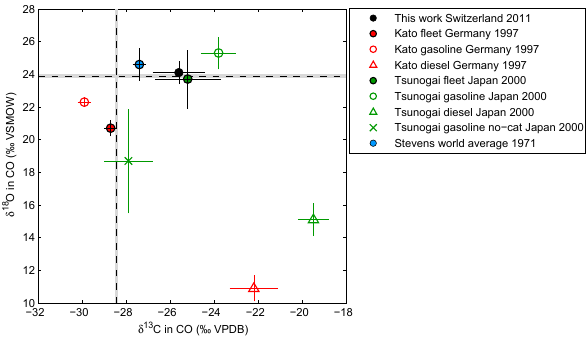
Fig. 6. δ 18 O versus δ 13 C in traffic CO from our work and previous studies: Kato et al., 1999a (Kato); Tsunogai et al., 2003 (Tsunogai); Stevens et al., 1972 (Stevens). The year shown in legend is the year when measurements were done. The dotted black lines indicate the δ 18 O in atmospheric oxygen (Barkan and Luz, 2005) and the aver- age δ 13 C value of the fuel in our study, as estimated from the δ 13 C value of CO 2 ; the shades indicate their standard errors, and their intersection shows the hypothetical CO isotopic composition in the absence of fractionation. The CO isotopic composition of gasoline vehicles from Kato et al. (1999a) is based on vehicles without a catalyst and one vehicle with catalyst functioning with cold